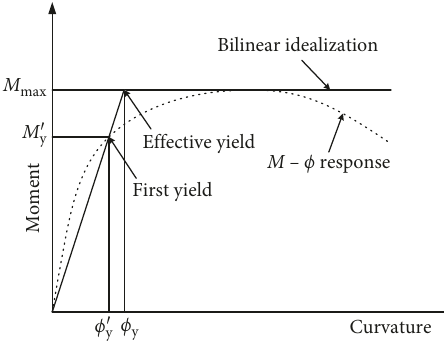
Figure 4: Definition of the effective yield